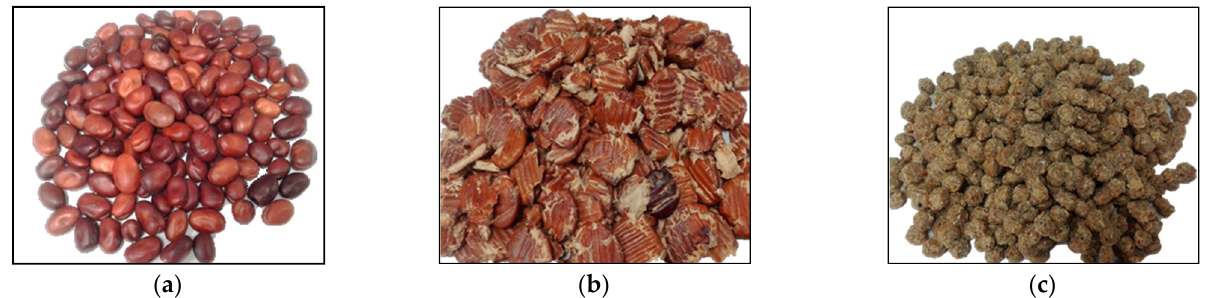
Figure 1. ( a ) Raw field beans ( Vicia faba ); ( b ) field beans mechanically crushed in a two-roller mill and treated with propionic acid (trFB). ( c ) Field beans mechanically crushed in a two-roller mill, treated with propionic acid and extruded (exFB) at 105 °C 5 × 5 × 6 mm die (EXTRU-tech E525, Sabetha, KS, USA).